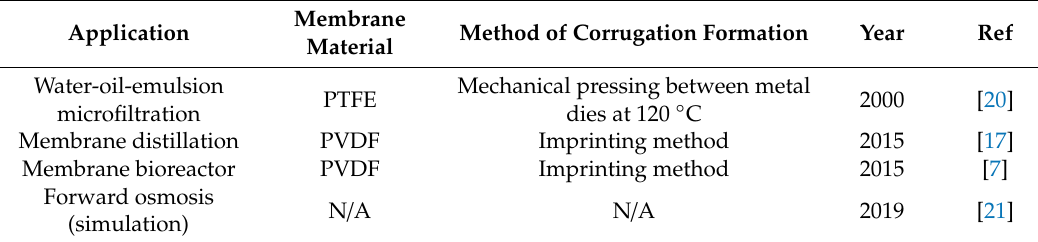
Table 1. Recent report on a corrugated membrane and corrugated membrane